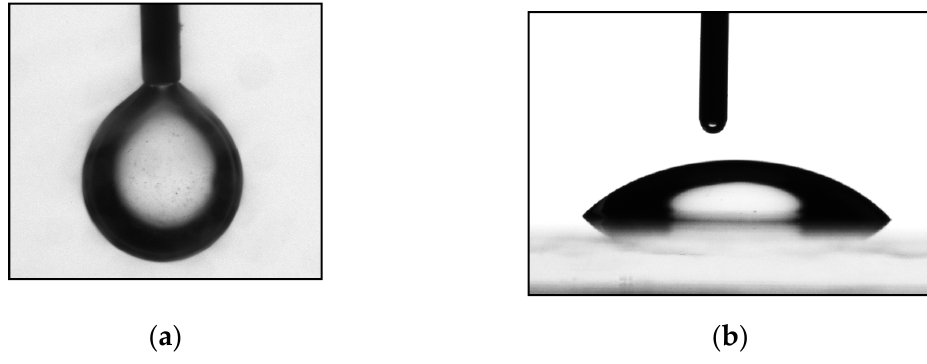
Figure 2. Evaluation of the surface tension ( a ) and the contact angle ( b ).